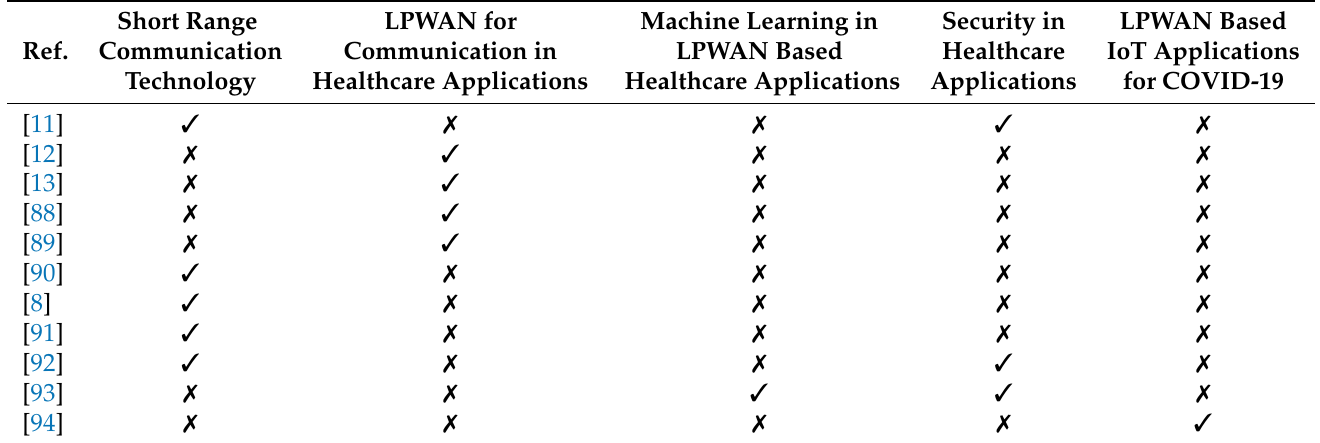
Table 1. Comparative analysis of related surveys for healthcare applications.